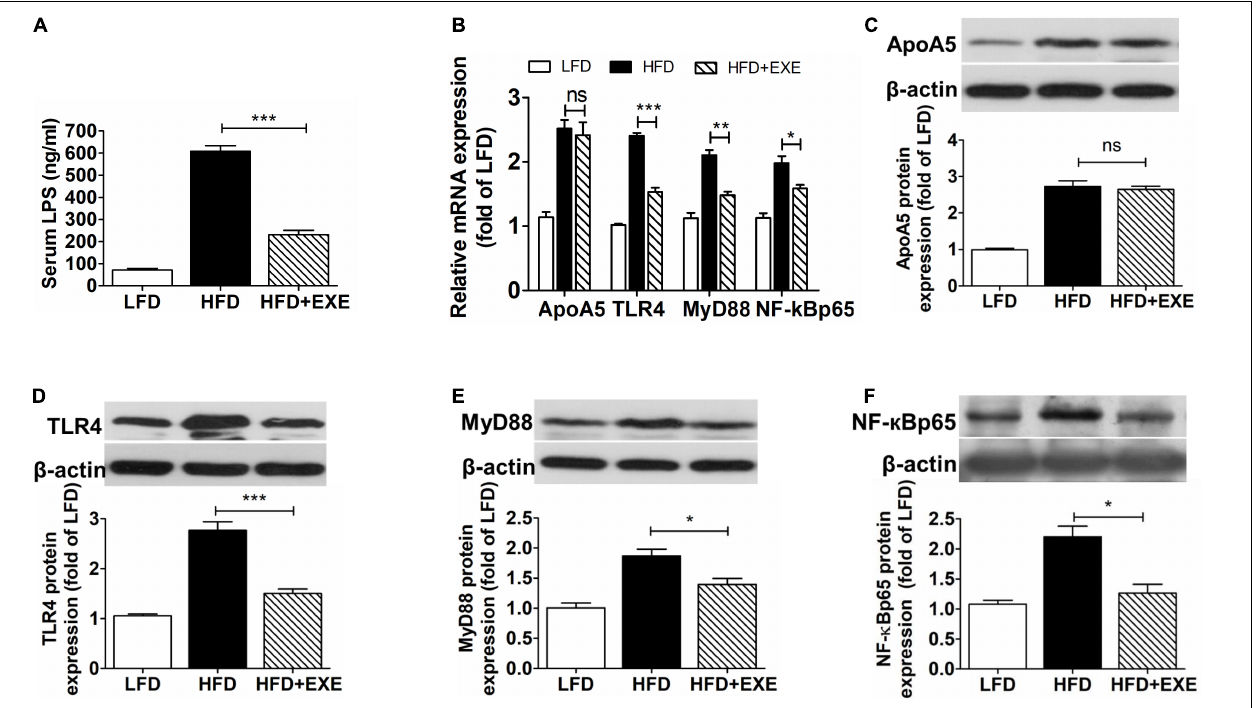
FIGURE 2 | Exercise did not affect hepatic ApoA5 expression but reduced hepatic TLR4-mediated pathway components and circulating LPS concentrations. Circulating LPS concentrations (A) . Hepatic mRNA levels of ApoA5, TLR4, MyD88, and NF- κ Bp65 (B) . Western blot analyses of ApoA5 (C) , TLR4 (D) , MyD88 (E) , and NF- κ Bp65 (F) . Results are presented as the mean ± SEM, n = 4–6 per group. * P < 0.05, ** P < 0.01, *** P < 0.001, and ns P > 0.05 (no